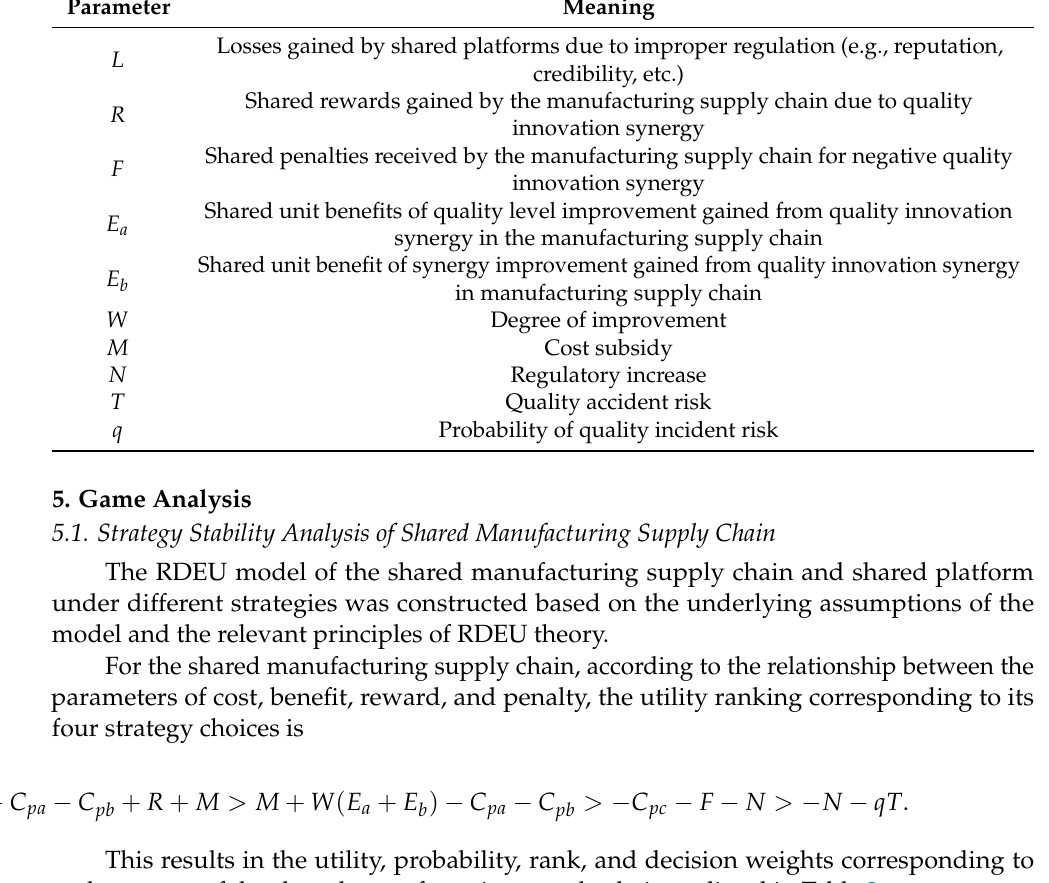
Table 2. Cont . Parameter Meaning Losses gained by shared platforms due to improper regulation (e.g., reputation, L credibility, etc.) Shared rewards gained by the manufacturing supply chain due to quality R innovation synergy Shared penalties received by the manufacturing supply chain for negative quality F innovation synergy Shared unit benefits of quality level improvement gained from quality innovation E a synergy in the manufacturing supply chain Shared unit benefit of synergy improvement gained from quality innovation synergy E b in manufacturing supply chain W Degree of improvement M Cost subsidy N Regulatory increase T q